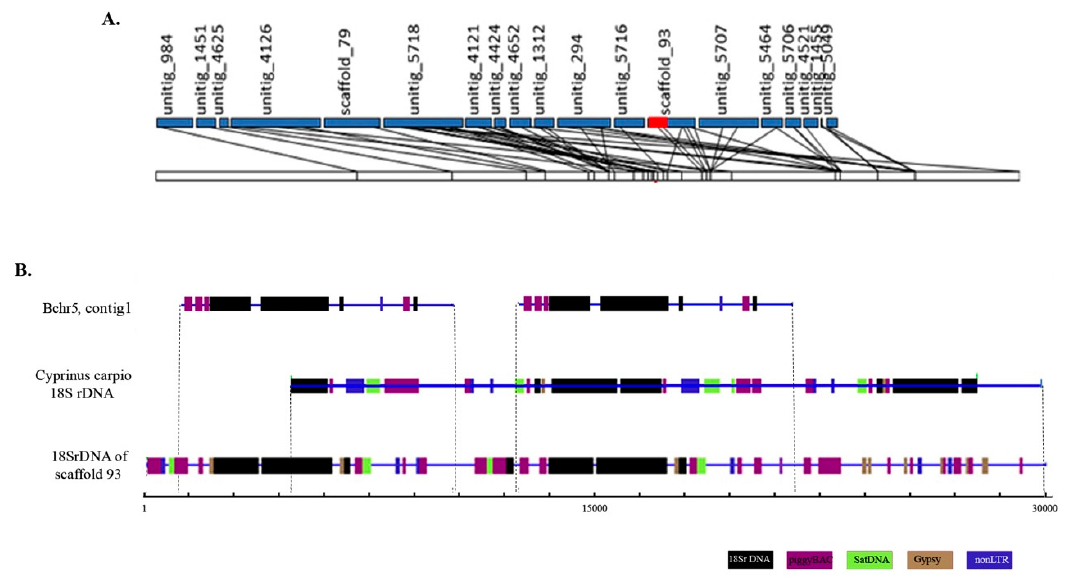
Figure 3. The 18S rDNA region of B chromosome 5 (Bchr5) shows a complex arrangement of various fragments of transposable elements with ribosomal genes and is different from the 18S rDNA region of the Asian seabass autosomal chromosomes. ( A ) Diagrammatic representation of genetic linkage group 5 (LG5). The ribosomal region located on genomic scaffold_93 assigned to LG5 is labeled in red. ( B ) Alignment of ribosomal genes containing the region of scaffold_93 of the Asian seabass genome, contig 1 of micro-dissected Bchr5 and rRNA sequence of Cyprinus carpio (9426 bp; JN628435). Various fragments of repetitive elements are indicated as follows: Satellite DNA (green), piggy BAC and R2 (violet), Gypsy (brown), and 18S rDNA (black).